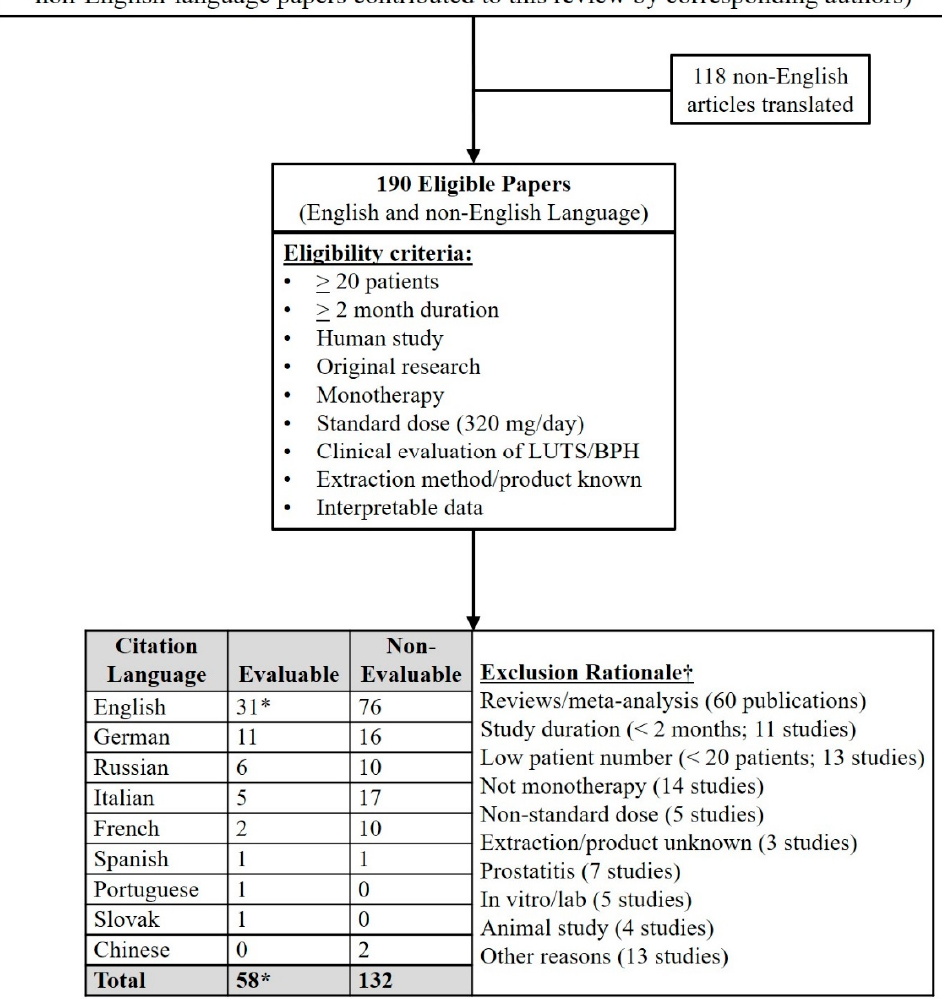
Figure 1. Disposition of 190 eligible papers. * Sixty evaluable studies (31%) with one duplication. Since Robert 2015 [4] and Latil 2015 [5] were separate papers but reported the same data they were counted as one study. † May contain more than one reason for exclusion.